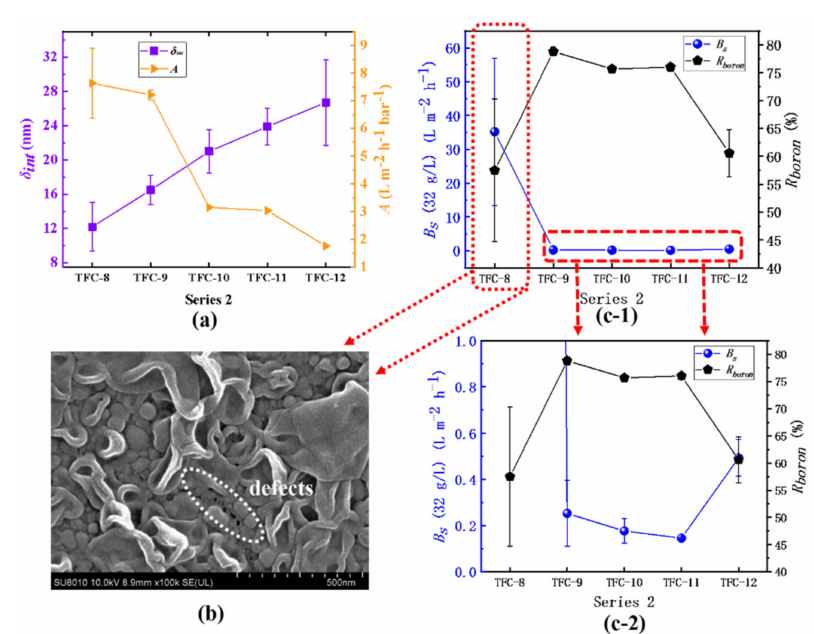
Figure 11. Series 2: ( a ) the variation in the A value and the δ int ; ( b ) SEM image of TFC − 8; ( c-1 ) and ( c-2 ) the analysis of the B s and the R boron